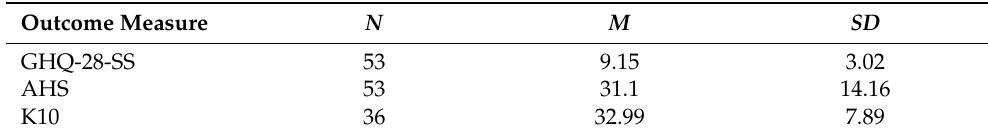
Table 2. Pre-intervention/baseline outcome measure mean